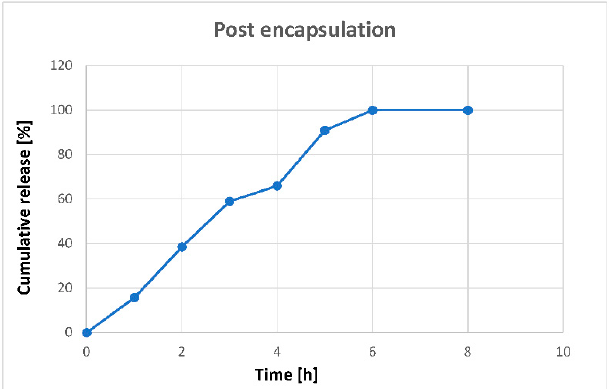
Figure 7. Release of bacteriophage from MPs. Bacteriophage release was measured over time after suspending the MPs in PBS.